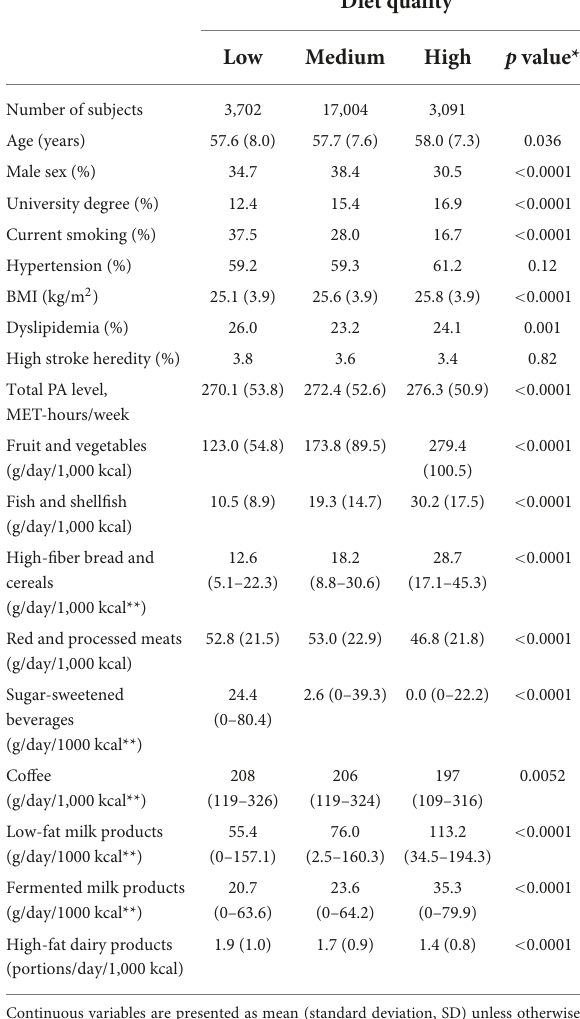
TABLE 1 Baseline characteristics across categories of diet quality. TABLE 2 Baseline characteristics across tertiles of total physical activity (PA)